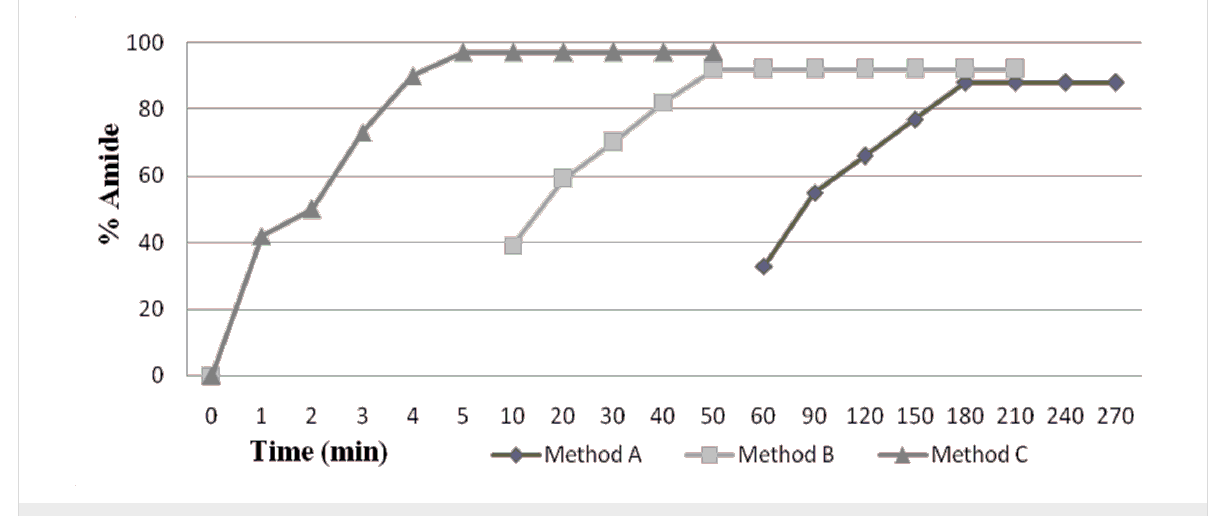
Figure 1: Effect of different methods using 20 mg of enzyme at 60 °C; Method A: conventional method, Method B: solution phase method, Method C: solid support method.